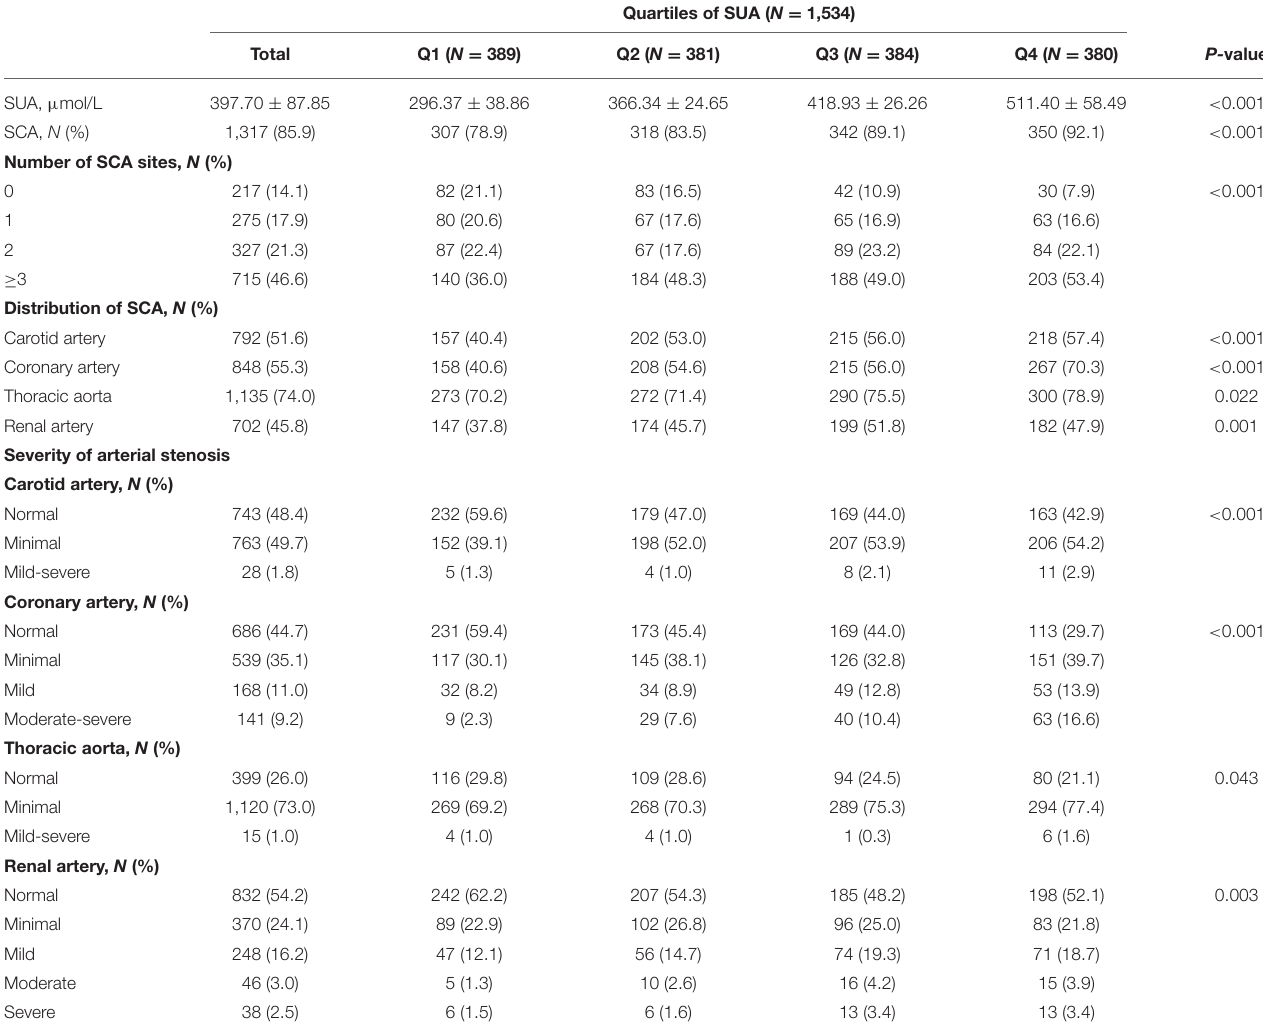
TABLE 2 | Prevalence of SCA according to quartiles of SUA